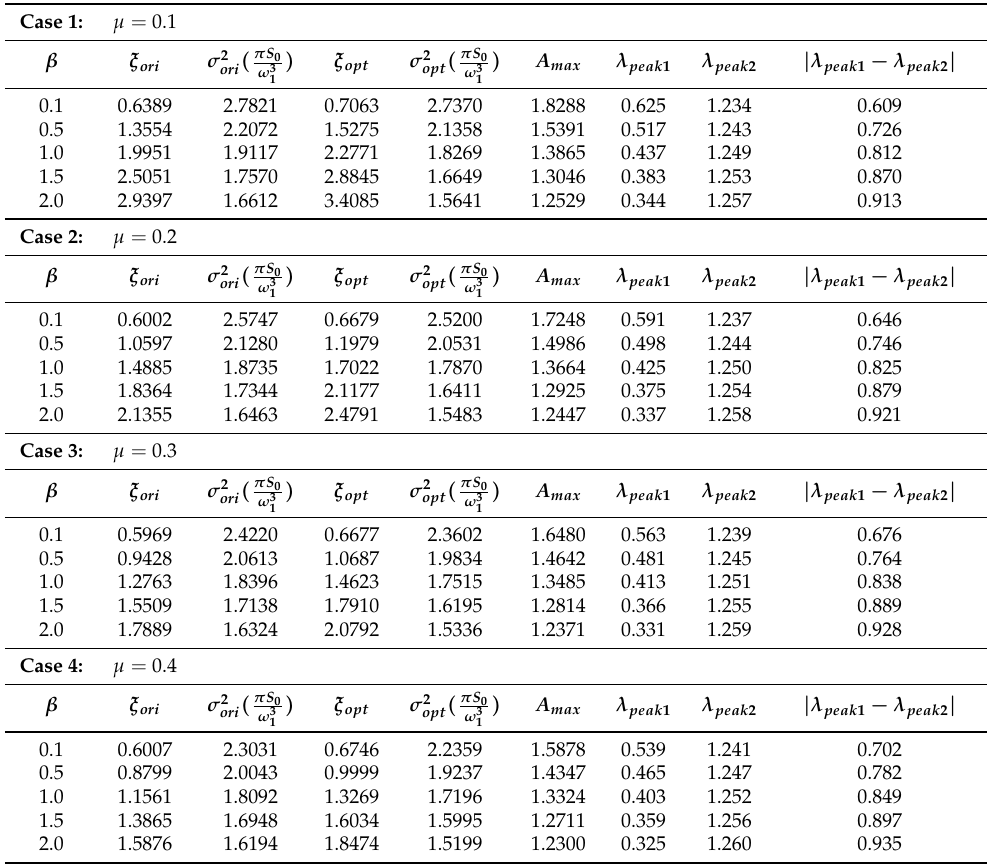
Table 2. The specific parameters of the system in different cases of the inerter-to-mass ratio when optimizing the single variable ξ ( α 2 opt = α 2 b